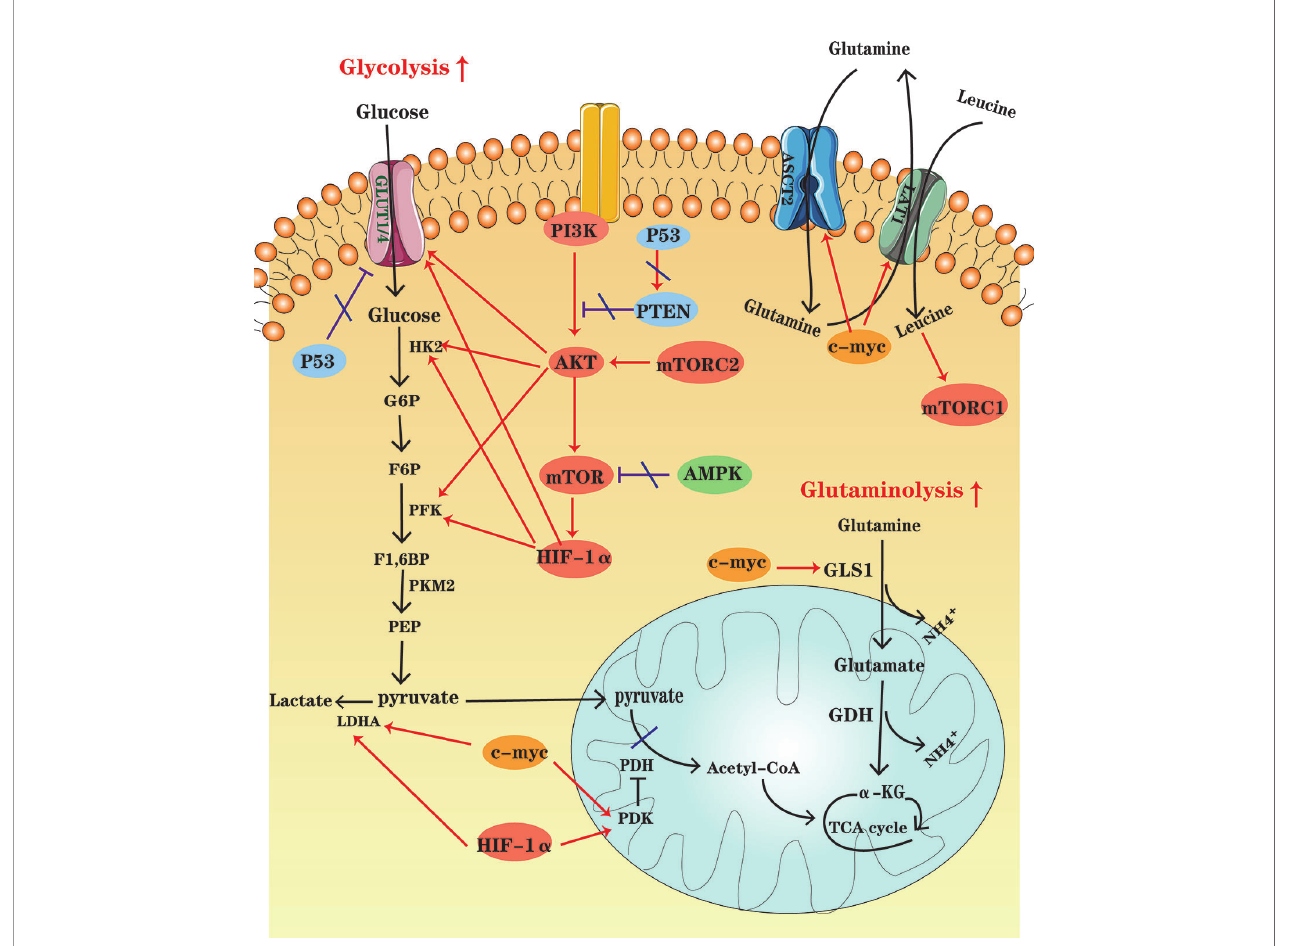
FIGURE 2 | An overview of cellular metabolic pathways in MM cells. In MM cells, PI3K-AKT-mTOR pathway up-regulation, the high HIF-1 expression and the increased c-myc activity enhance glycolysis and glutaminolysis, which foster expression of key enzymes and transporters. At the same time, AMPK down-regulation, as well as P53 de fi ciency contribute to the metabolic reprogramming of MM cells in the glycolytic